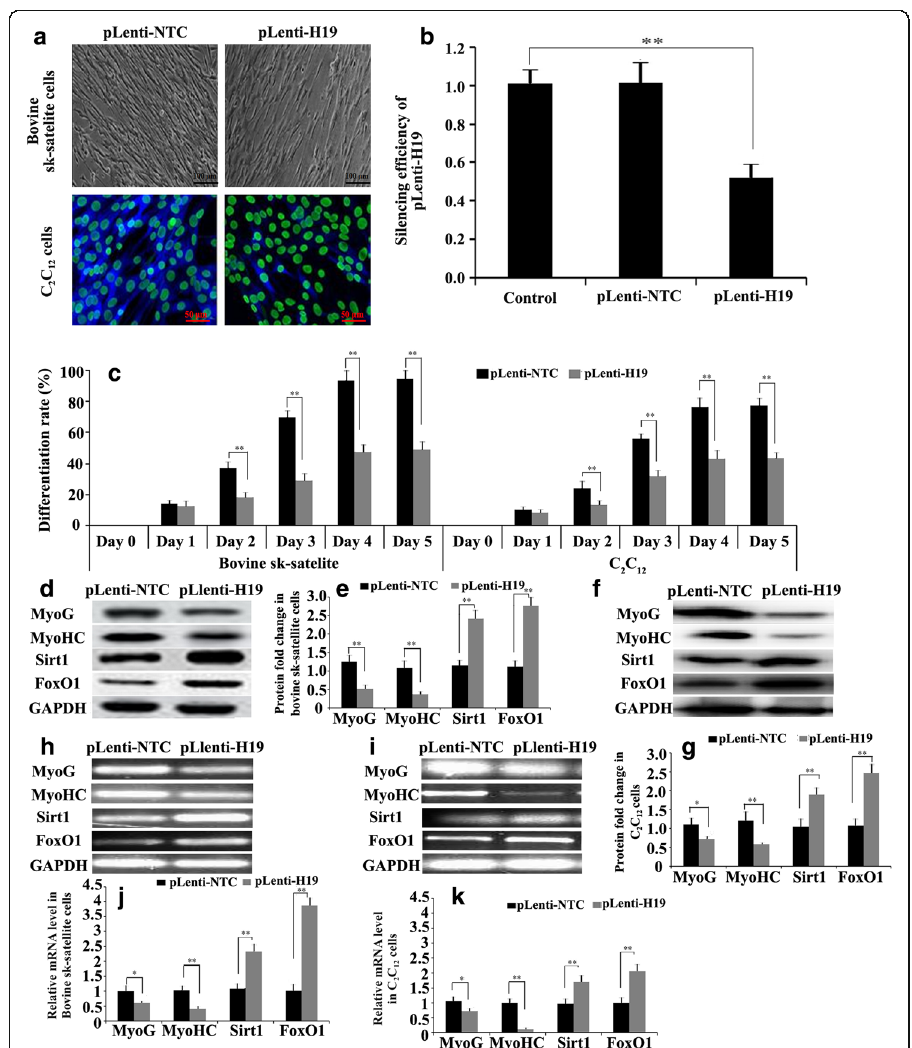
Fig. 3 Knockdown of H19 suppressed the differentiation of bovine tibia skeletal muscle (sk-muscle) satellite and C 2 C 12 cells. a The immunofluorescence results for C 2 C 12 cells and satellite cells on day 4 of differentiation. b The silencing efficiency of pLenti-H19. Cells with pLenti-NTC were the negative control and wild-type cells were the blank control (control). c The differentiation rate of C 2 C 12 cells and the satellite cells on days 1, 2, 3, 4 and 5. ( d , e , f and g ). Detection of myoblast marker and myoblast inhibitory genes based on the protein level after H19 was silenced by pLenti-H19 vector transfection in bovine sk-muscle satellite cells ( d , e ) and C 2 C 12 cells ( f , g ). h , i RT-PCR results for bovine sk-muscle satellite cells ( h ) and C 2 C 12 cells ( i ) after H19 was silenced by pLenti-H19 vector transfection. j , k . mRNA level of bovine sk-muscle satellite cells ( j ) and C 2 C 12 cells ( k ) after H19 was silenced by pLenti-H19 vector transfection. pLenti-NTC was the negative control. The blank control was the mRNA of satellite and C 2 C 12 cells without any treatment, with cultivation for the same number of days. GAPDH was internal control. * p <0.05, ** p